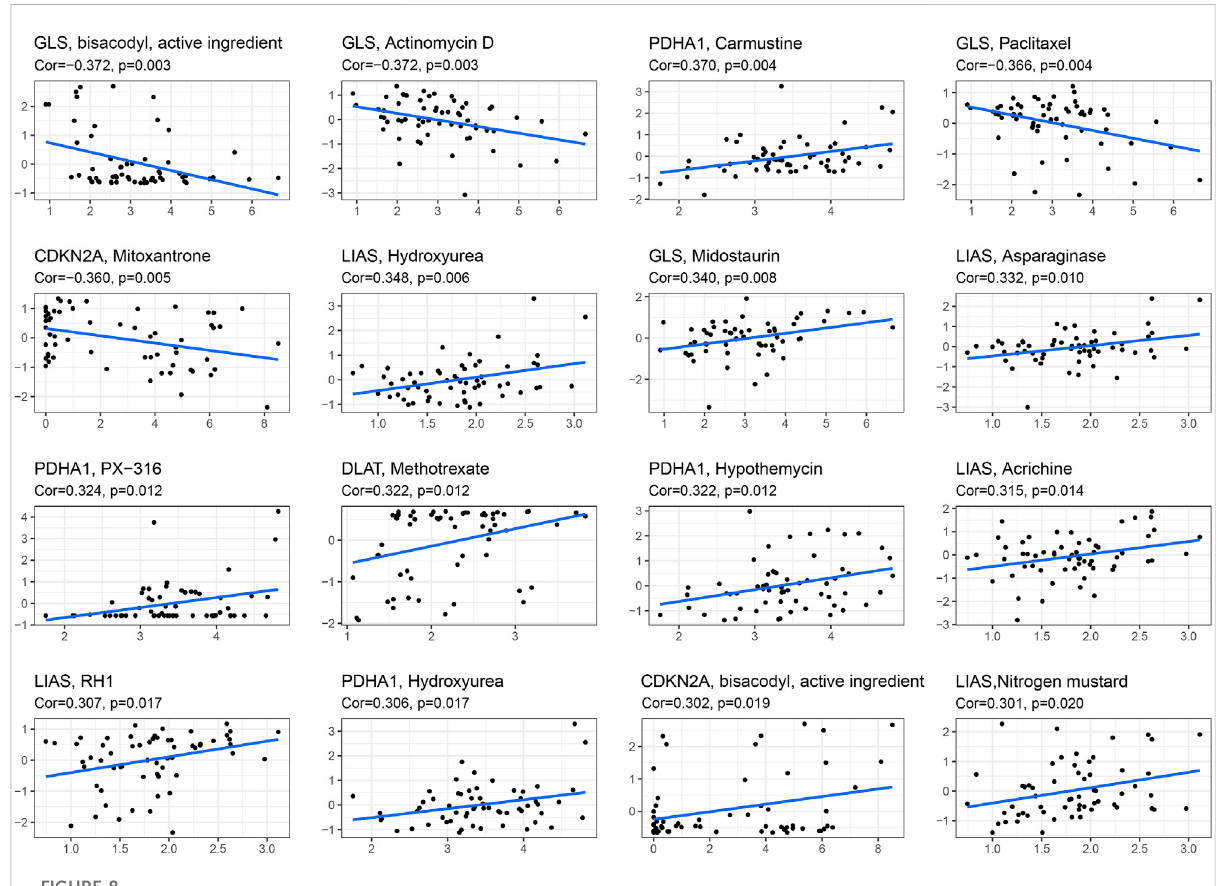
FIGURE 8 The relationship between cuproptosis-associated genes and drug